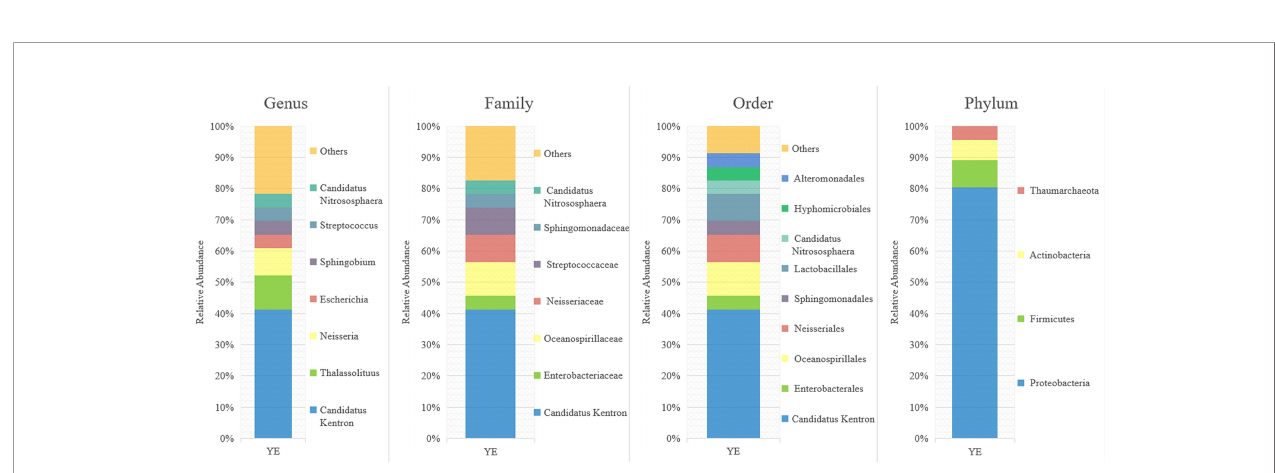
FIGURE 3 | Relative abundances of the bacterial major taxa in Kentrophoros fl avus YE are suggested by the clone library data. Members of the genus, “ Candidatus Kentron ” , are shown as the most frequently occurring